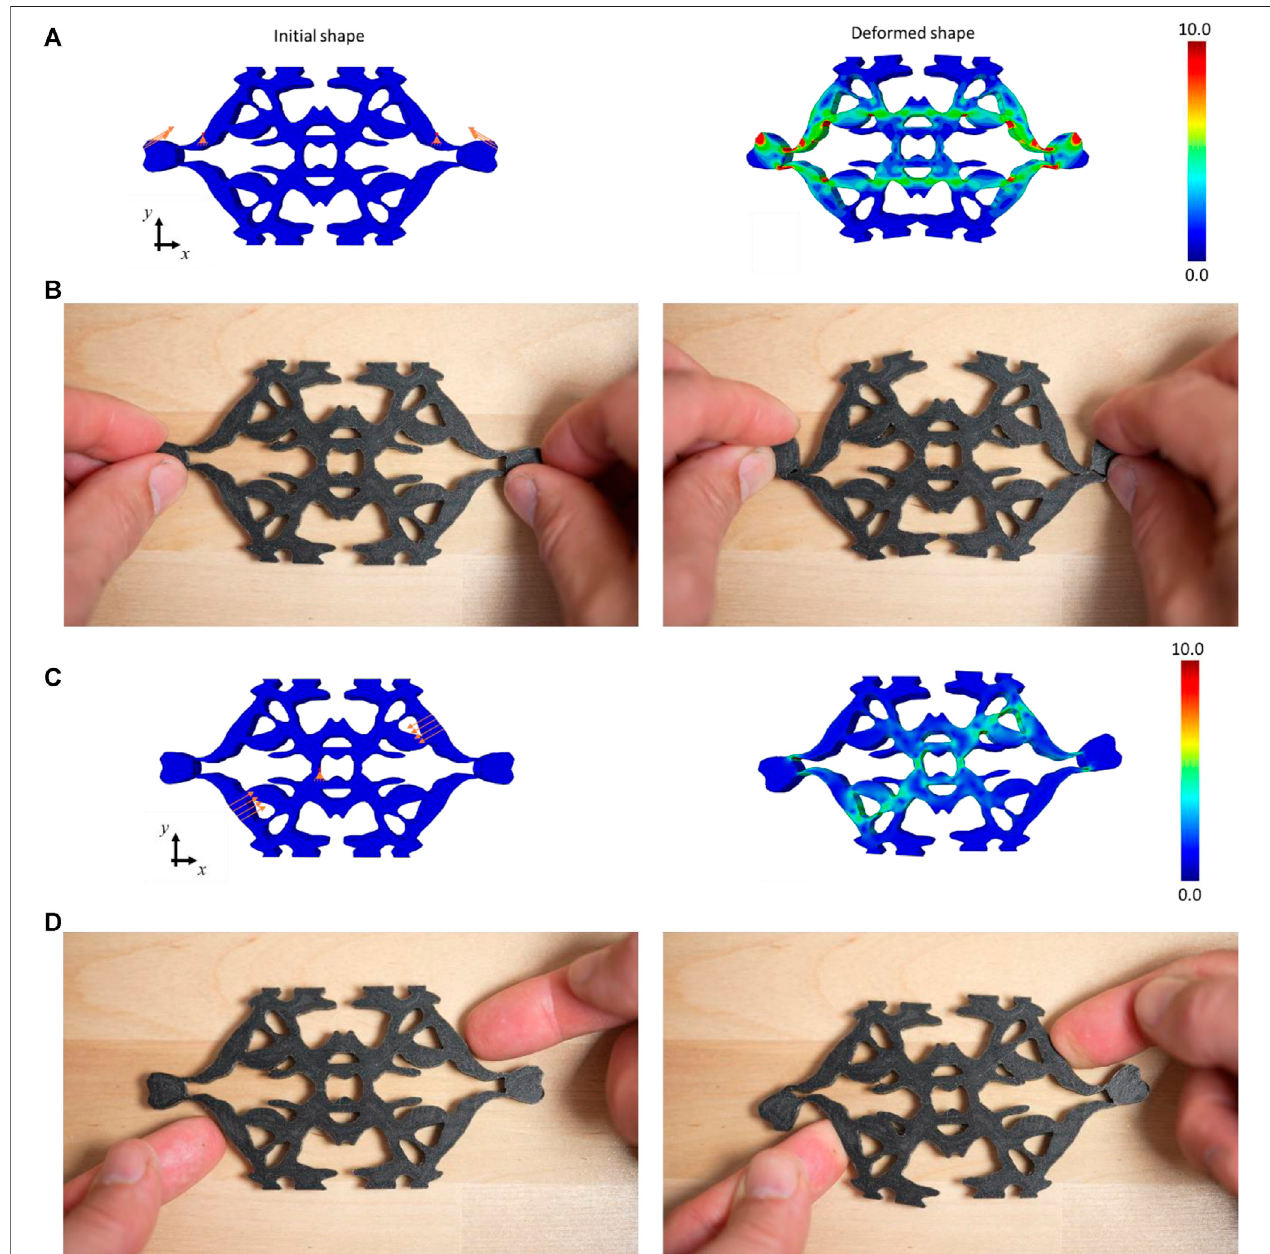
FIGURE 9| Mechanism realized through the design, computational (FEM) and experimental validation. FEM results to are shown in panels A and C to simulate the mechanismundertwodistinct loadingconditions(indicated inimage).Experimentalresults areshown inpanelsBand D ,respectively.Panels A and C snowstwistingof two handles. Panels B and D shows results under compression along the diagonal axis. The von Mises stress (MPa) is visualized in panels A and C to provide a quantitative analysis of the deformation process. Movies M1-2 show animations of the deformations based on FEM results, and Movies M3-4 shows the experimental analysis of the same